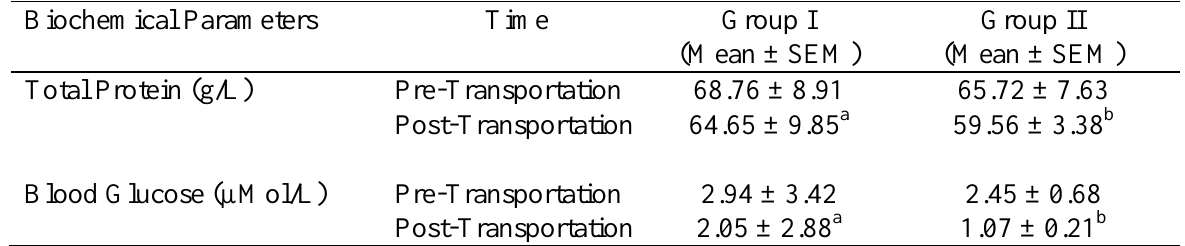
Table 4: Biochemical Parameters of Clarias gariepinus subjected to Road Transportation Biochemical